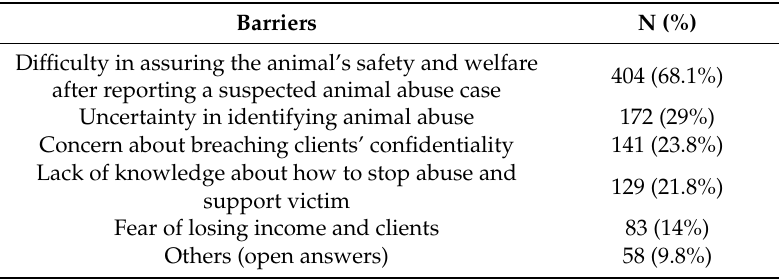
Table 5. Barriers associated with intervening in suspected animal abuse cases.